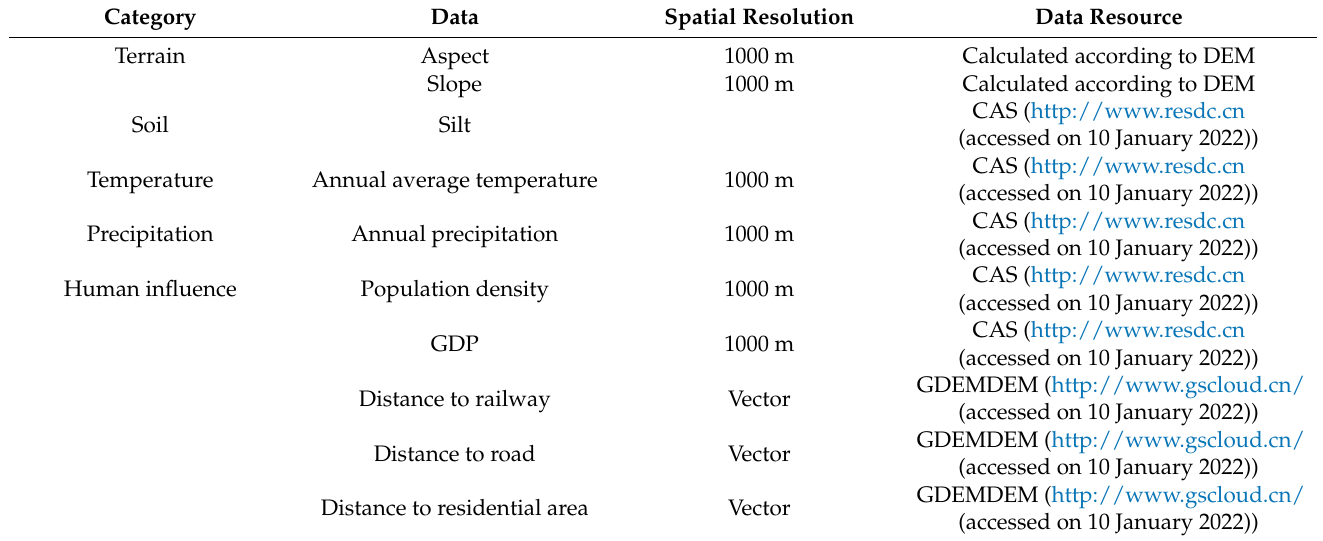
Table 1. A description of the data used in the model.